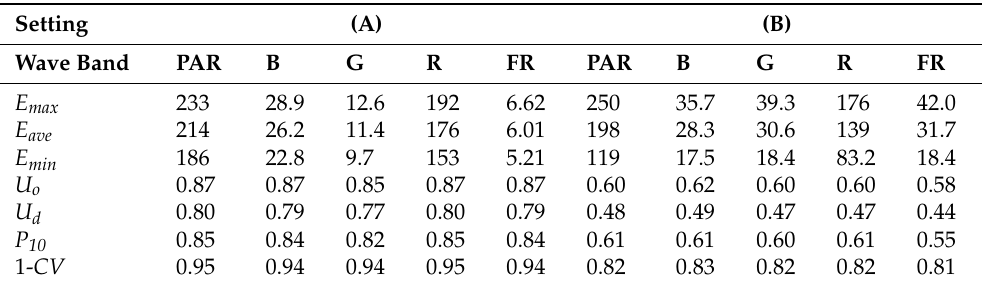
Table 1. Statistical parameters characterizing the photon irradiance distributions in the B, G, R, FR and PAR wavebands for illuminance settings (A),(B). The photon irradiance parameters ( E max , E ave , E min ) have unit µ mol · m − 2 · s − 1